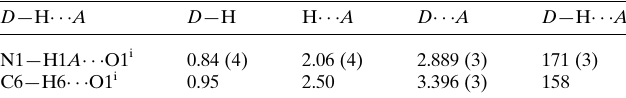
Table 1 Hydrogen-bond geometry (A˚ , (cid:4) ).